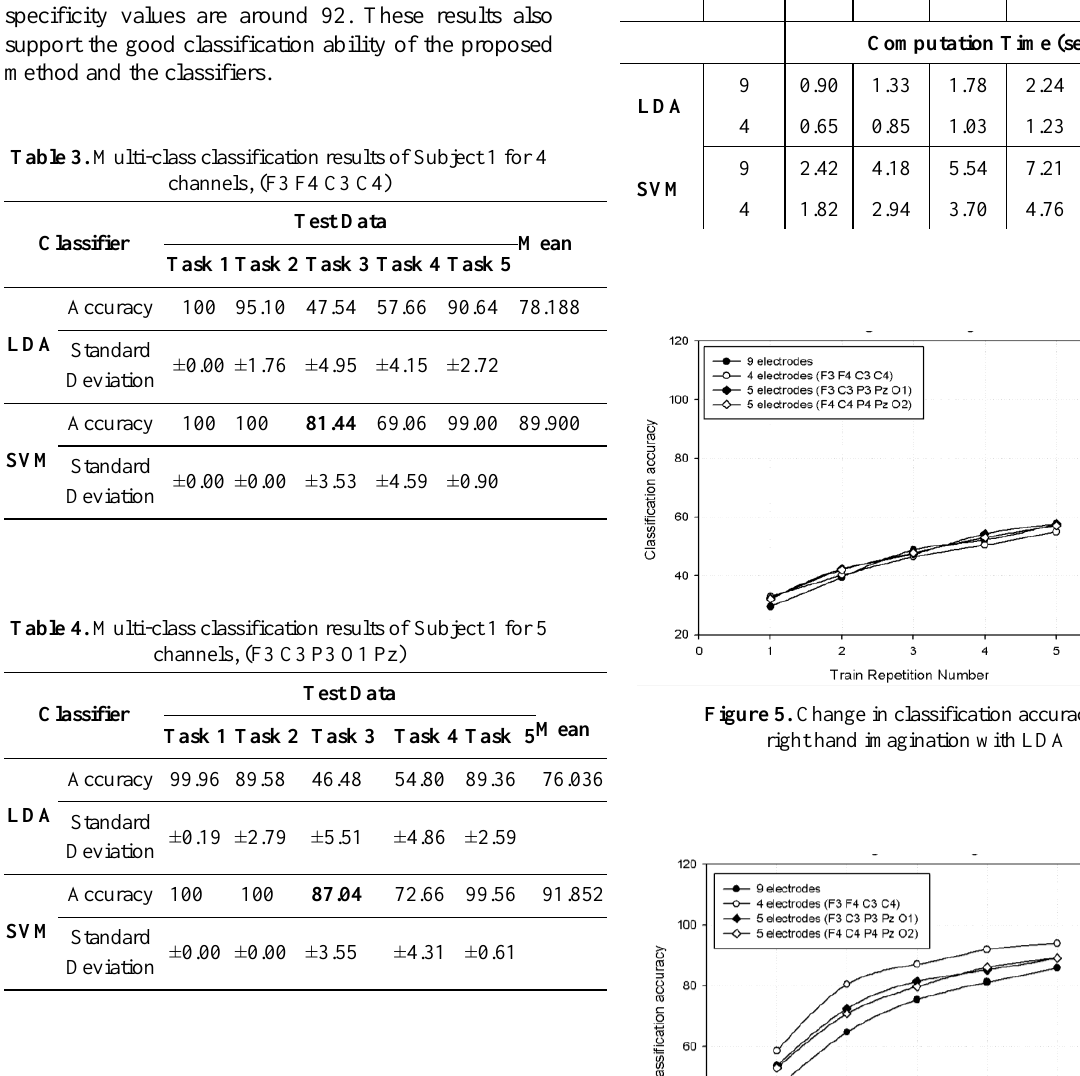
Table 5. Multi-class classification results of Subject 1 for 5